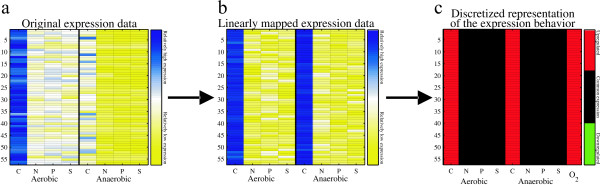
Heatmaps of a module. a) Normalized expression pattern of all (57) genes that share the same discretized representation, namely 100010001, and consequently, form a module. This representation, which indicates upregulation under carbon limitation and higher expression when grown within the presence of oxygen, is identical to the one derived in Figure 2. The expression patterns of the genes in this heatmap are comparable to the expression pattern in Figure 2a. b) Normalized expression pattern of the genes after the linear mapping is applied. Isolation of the oxygen effect clearly reveals upregulation under the carbon limitation. The linearly mapped expression patterns are comparable to the one in Figure 2c. c) The (identical) discretized expression pattern for the 57 genes. Note that our discretization procedure assigns a 0 to the cultivation conditions that form the most common expression level. For these 57 genes this common expression level is represented in b by the dark yellow, which occurs in six of the eight conditions. The ninth entry of this representation, i.e. the oxygen effect, is also characterized as upregulated, since the original expression levels in a are consistently higher under aerobic growth when compared to anaerobic growth.